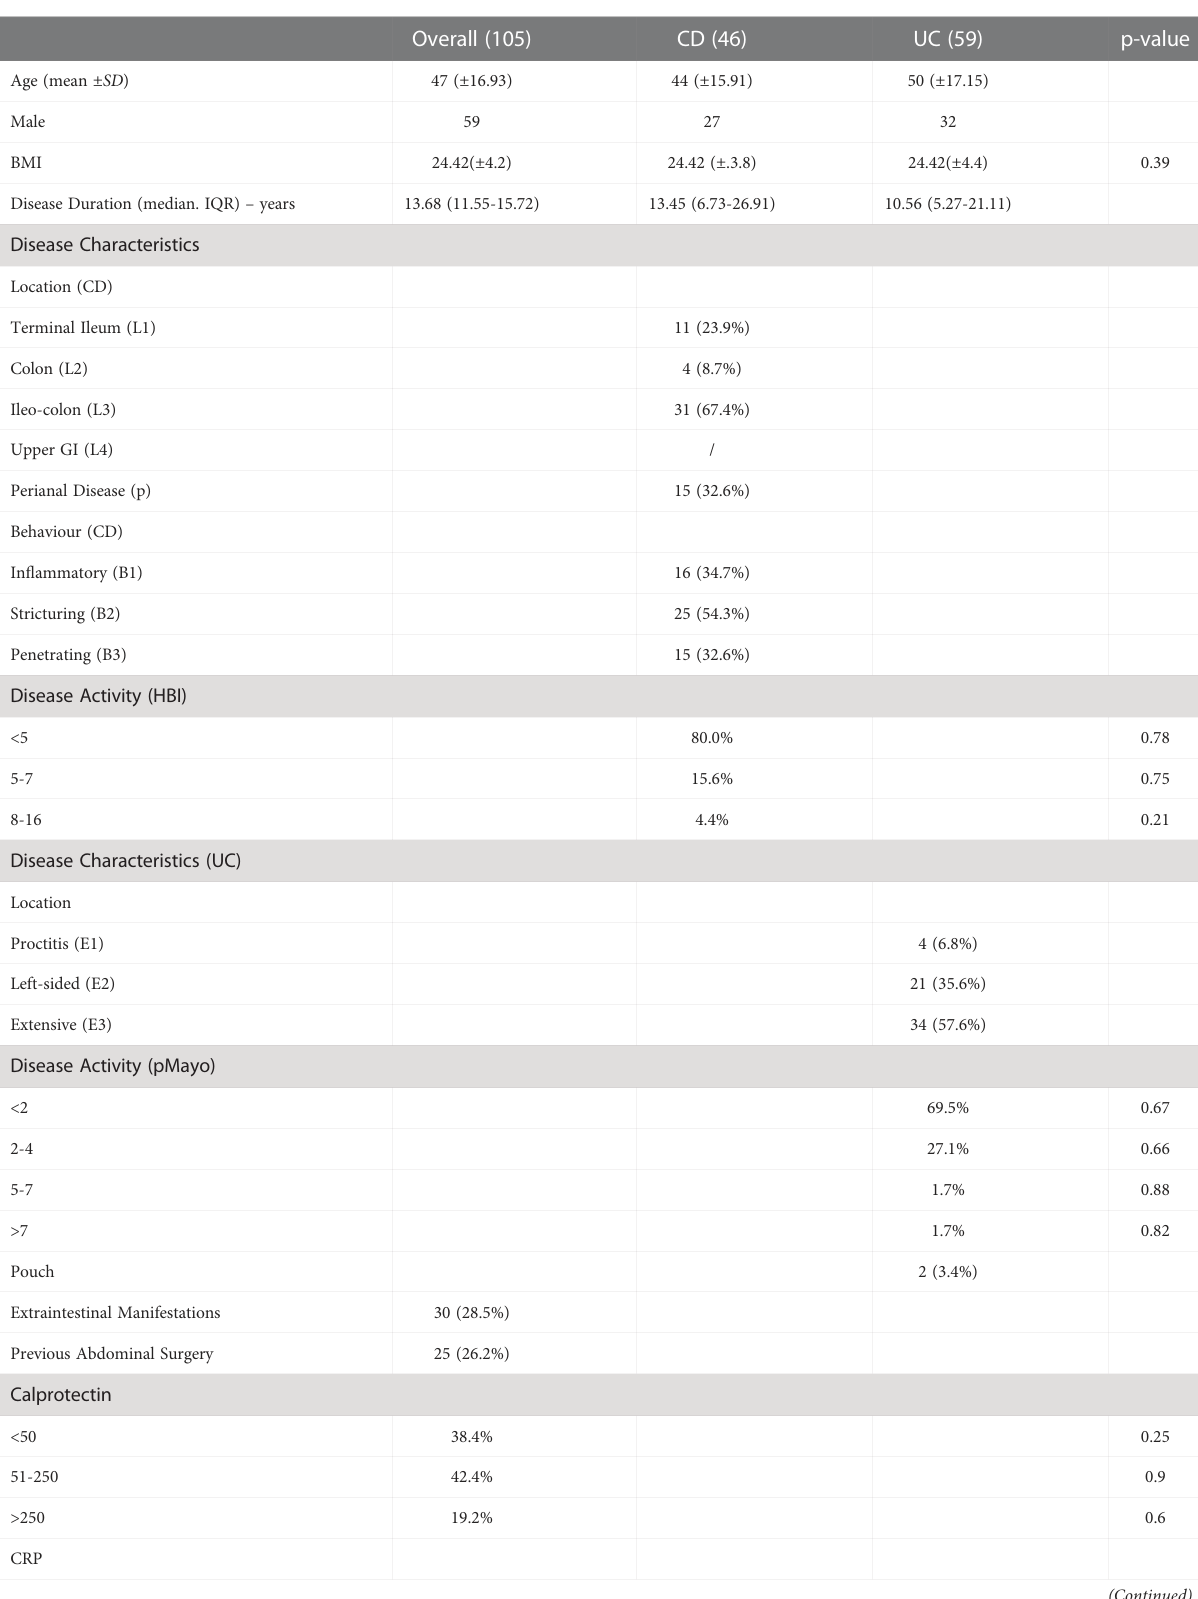
TABLE 1 Demographic and clinical characteristics of the cohort under